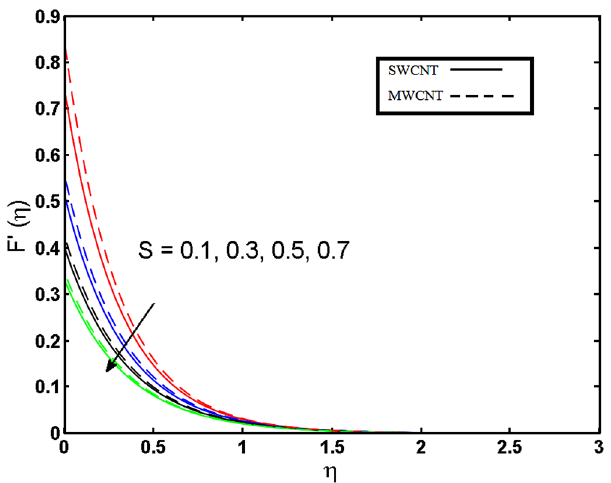
Figure 2. Illustration of a velocity profile F ′ (η) for different values of S .